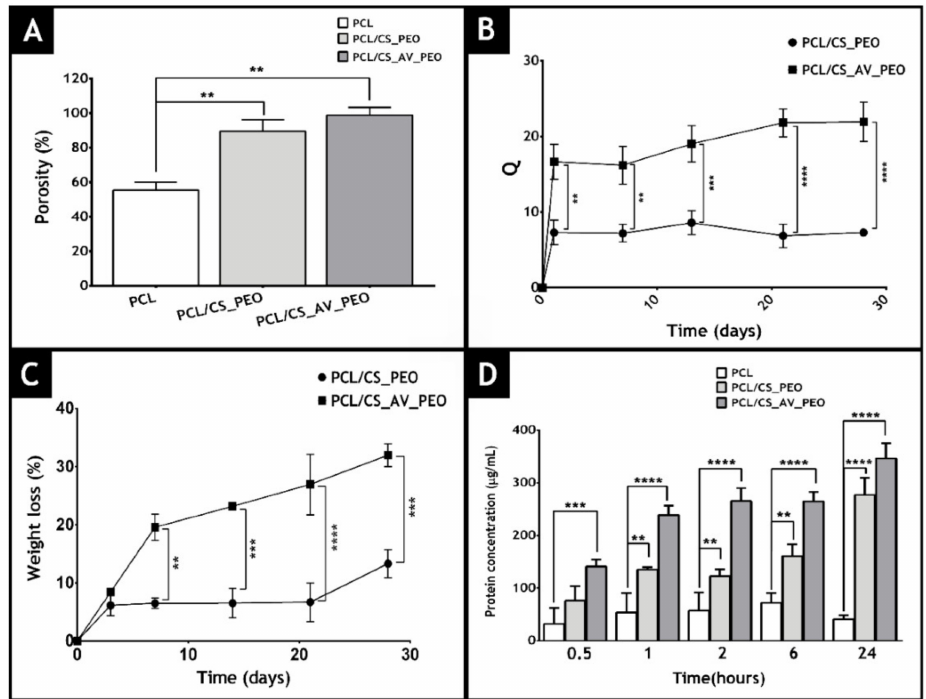
Figure 8. Characterization of the total porosity ( A ), swelling profile ( B ), weight loss ( C ), and protein adsorption ( D ) on the membrane’s surface at different time points. Reproduced from Ref.